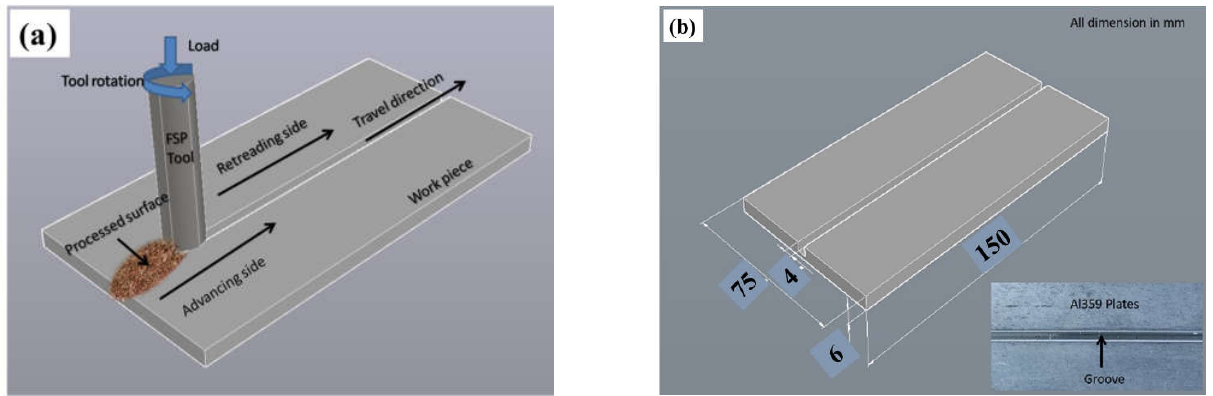
Figure 1. Schematic arrangement of the ( a ) friction stir processing and ( b ) aluminium alloy AL359